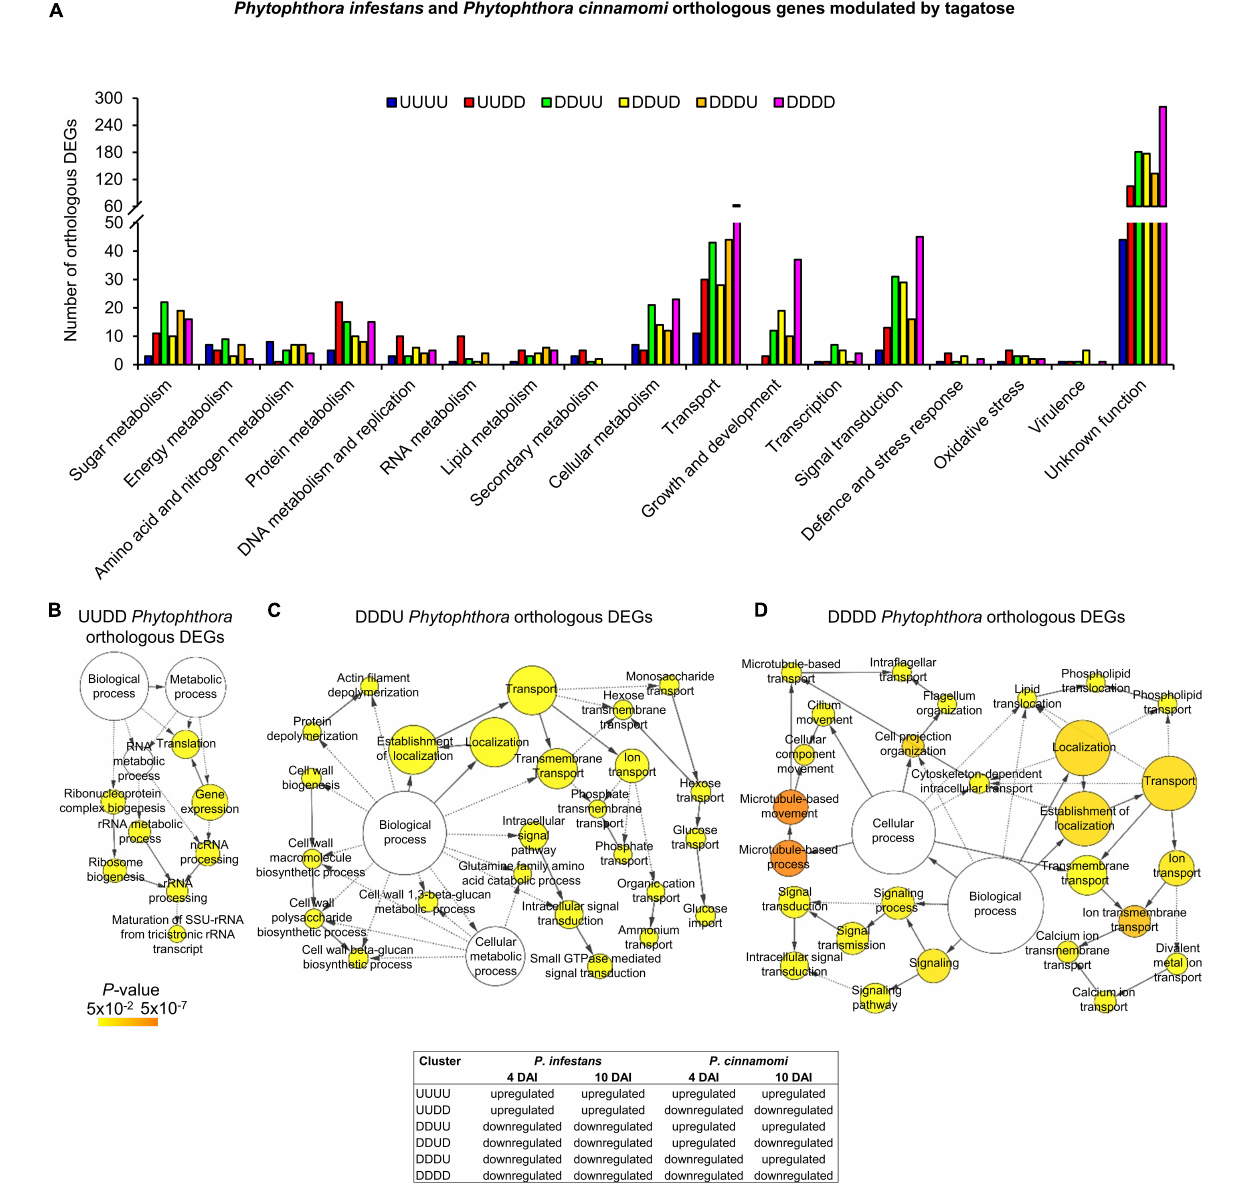
FIGURE 6 | Functional annotation of P. infestans and P. cinnamomi orthologous genes modulated by tagatose. Orthologous genes of P. infestans and P. cinnamomi differentially expressed (orthologous DEGs) were identified at 4 and 10 days after incubation (DAI) on pea agar medium in the presence of tagatose compared to the respective control samples grown in the absence of tagatose. Orthologous DEGs were grouped in 16 clusters (defined by a four-letter code) based on their upregulation (U) or downregulation (D) in tagatose-incubated samples ( Supplementary Table 11 ): P. infestans at 4 DAI (first letter); P. infestans at 10 DAI (second letter); P. cinnamomi at 4 DAI (third letter); P. cinnamomi at 10 DAI (fourth letter); such as the cluster of genes upregulated in P. infestans and downregulated in P. cinnamomi at 4 and 10 DAI (UUDD). Functional categories (A) of the clusters UUUU (blue), UUDD (red), DDUU (green), DDUD (yellow), DDDU (orange) and DDDD (pink) were assigned based on the protein description. Biological networks of significantly enriched ( P ≤ 0.05) Gene Ontology (GO) terms of UUDD (B) , DDDU (C) , and DDDD (D) cluster of orthologous DEGs were identified using the BiNGO tool and visualized with Cytoscape software. The color scale legend indicates the level of significance for enriched GO terms and white nodes indicate not significantly overrepresented categories. Dotted lines indicate connection between biological process categories in the GO chart, where ancestor and child are omitted for simplicity. No significant GO enrichment was found for the UUUU, DDUU and DDUD